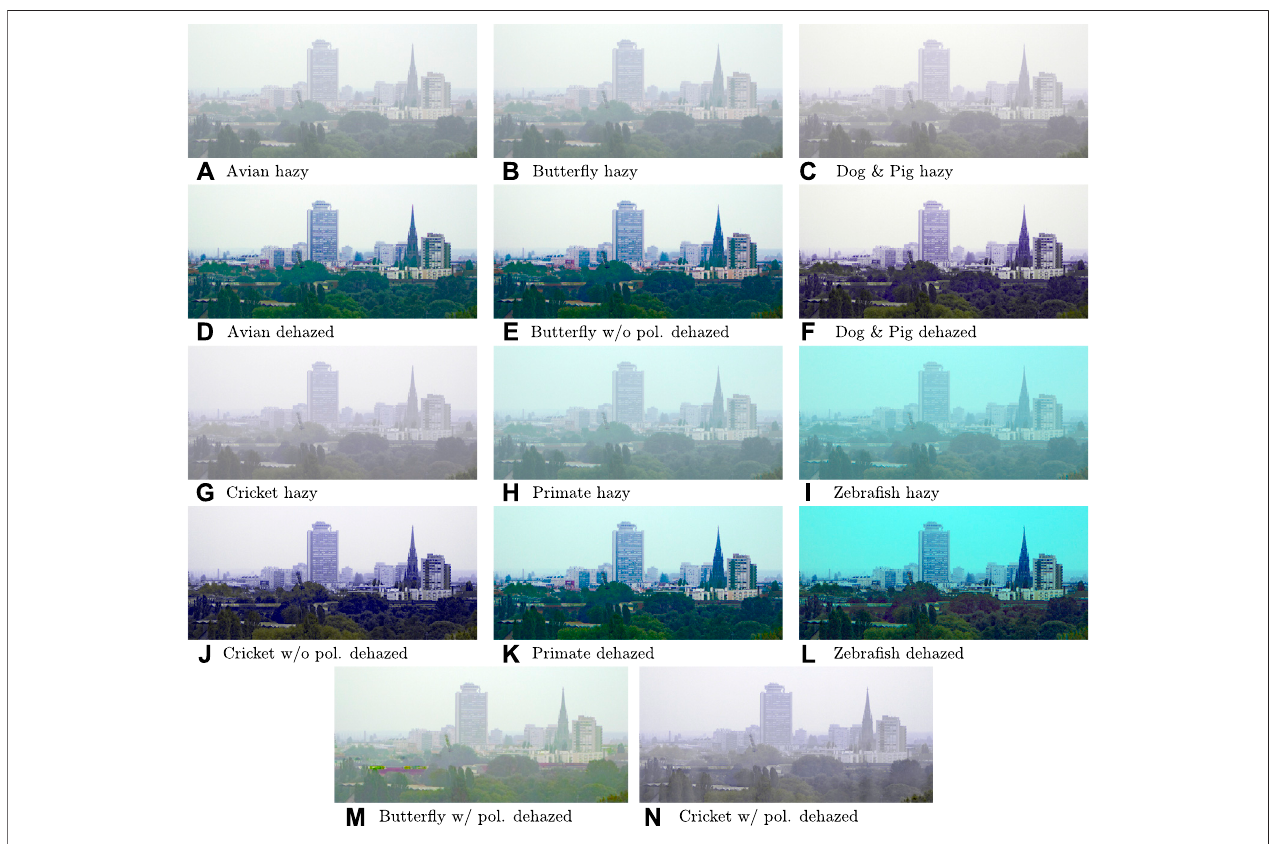
FIGURE 6 | sRGB visualization (scene 2) of images before and after dehazing for each animal.